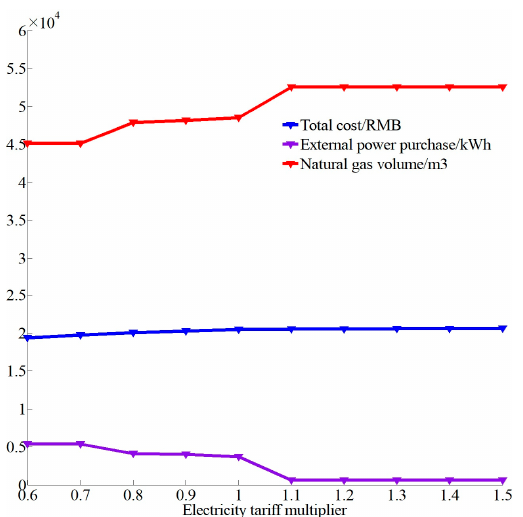
Figure 9. Total cost, external power purchase, and natural gas volume (natural gas price changes). The results for when the electricity tariff changes from 0.5 times the original price to 1.5 times are shown in Figure 10.